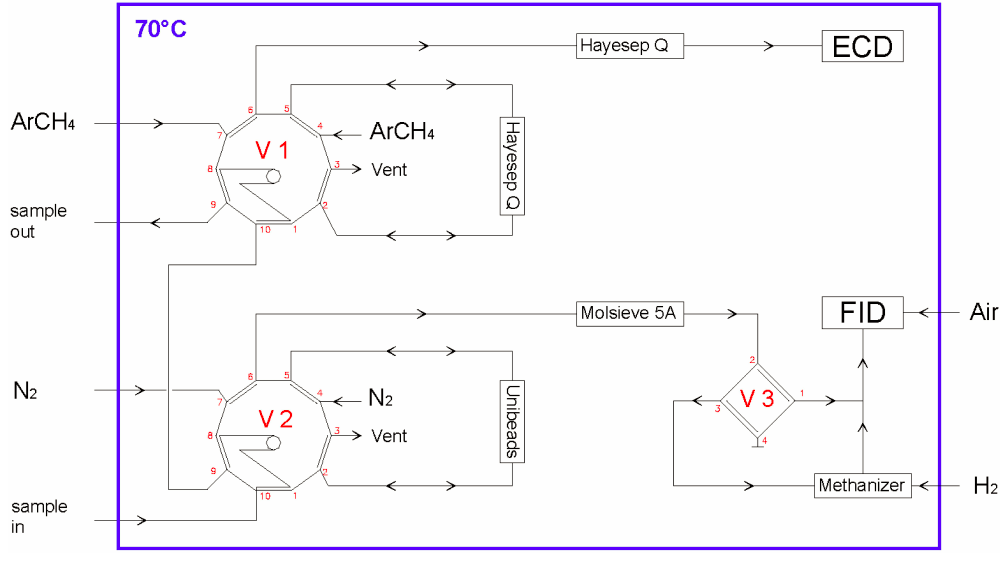
Fig. 5. Layout of the GC measurements system at Cabauw in period C1 from November 2004–February 2009. For further description see text.